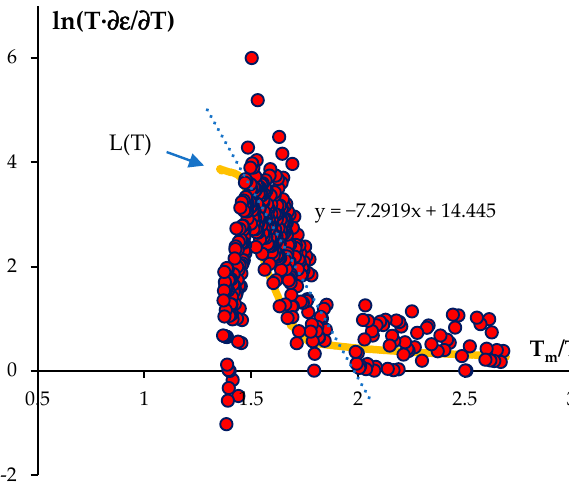
Figure 11. The dependence ln(T· ∂ ε / ∂ T)-T m /T for YPO 4 :Gd ceramic.